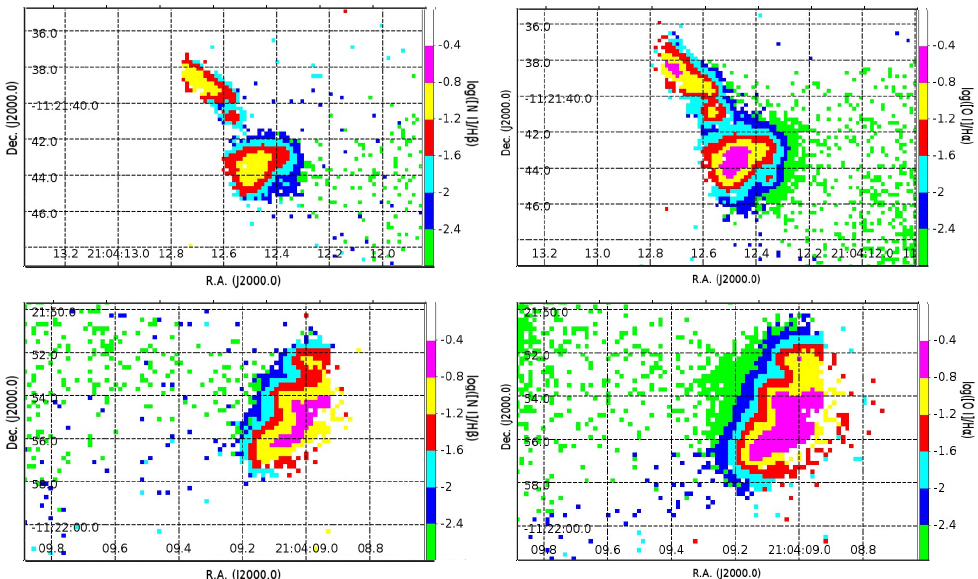
Figure 4. Log([N I ] λ 5200/H β ) ( left panels ) and log([O I ] λ 6300/H α ) ( right panels ) line ratios of the northeast ( upper panels ) and southwest ( lower panels ) LISs in NGC 7009.